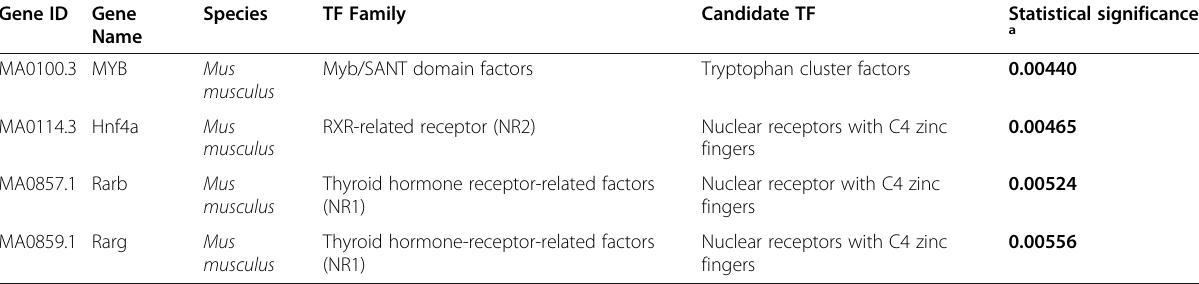
Table 3 List of matching candidate transcription factors (TFs) which could bind to common Mtrn I motif